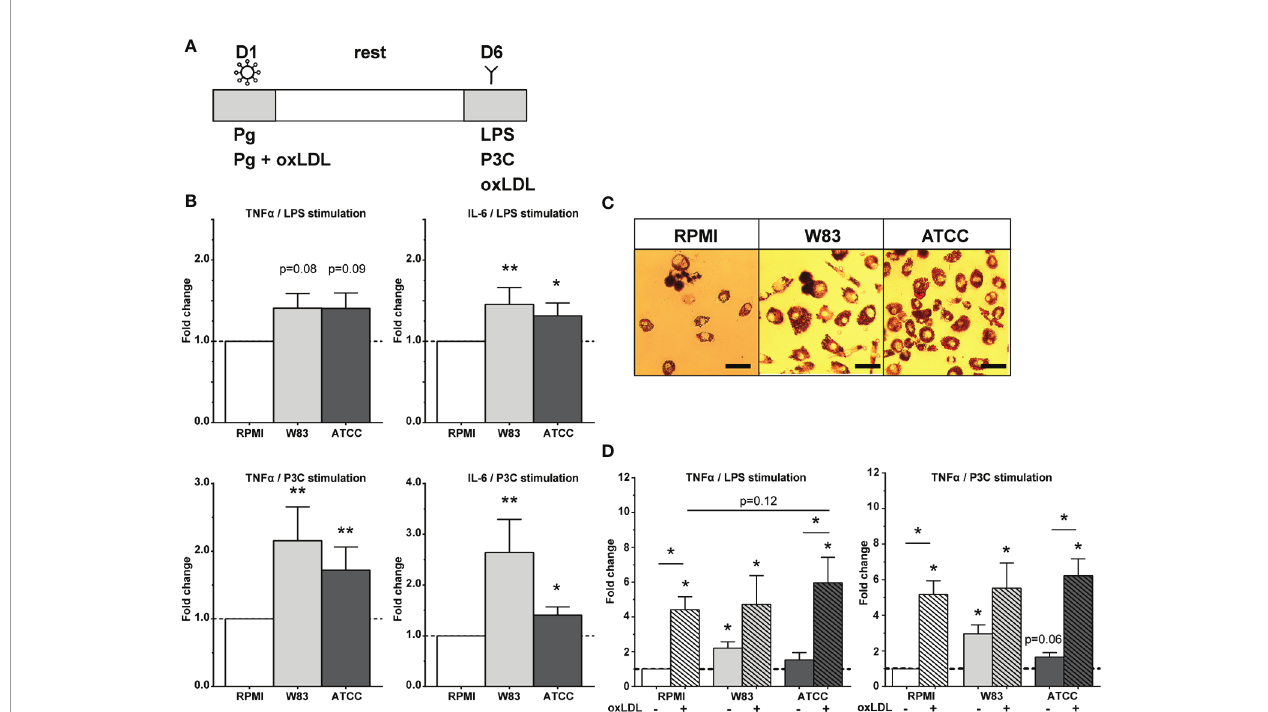
FIGURE 1 | Trained immunity by P. gingivalis . (A) Overview of trained immunity model. Adherent monocytes were trained for 24h on day 1 with Pg or Pg with oxLDL (10µg/mL). After 24h the training stimulus was washed away, the cells were rested for 6 days in supplemented RPMI after which the cells were restimulated on day 6 with RPMI, LPS, or P3C for 24h (without oxLDL) to measure cytokine production, or they were exposed to oxLDL (25 µg/mL) for 24 hours to induce foam cell formation. On day 7, TNF a and IL-6 concentrations were measured in the supernatants. (B) P. gingivalis induces trained immunity as shown by the increased fold change of TNF a and IL-6 (n=20, *p < 0.05, **p < 0.01). (C) Foam cell formation by P. gingivalis using Oil Red O staining. Magni fi cation x40, scale bar 50µm (n=6, representative picture is shown). (D) P. gingivalis in combination with oxLDL exposure for 24h on day 1 increased training response (n = 6, *p < 0.05). Data are presented as fold change with mean ± SEM. P. gingivalis -trained cells were compared to RPMI-incubated control cells at day 1 after restimulation with LPS or P3C at day 6. Wilcoxon signed-rank test. Pg, P. gingivalis ; oxLDL, oxidized LDL; W83, Pg W83 strain; ATCC, Pg ATCC strain; RPMI, medium